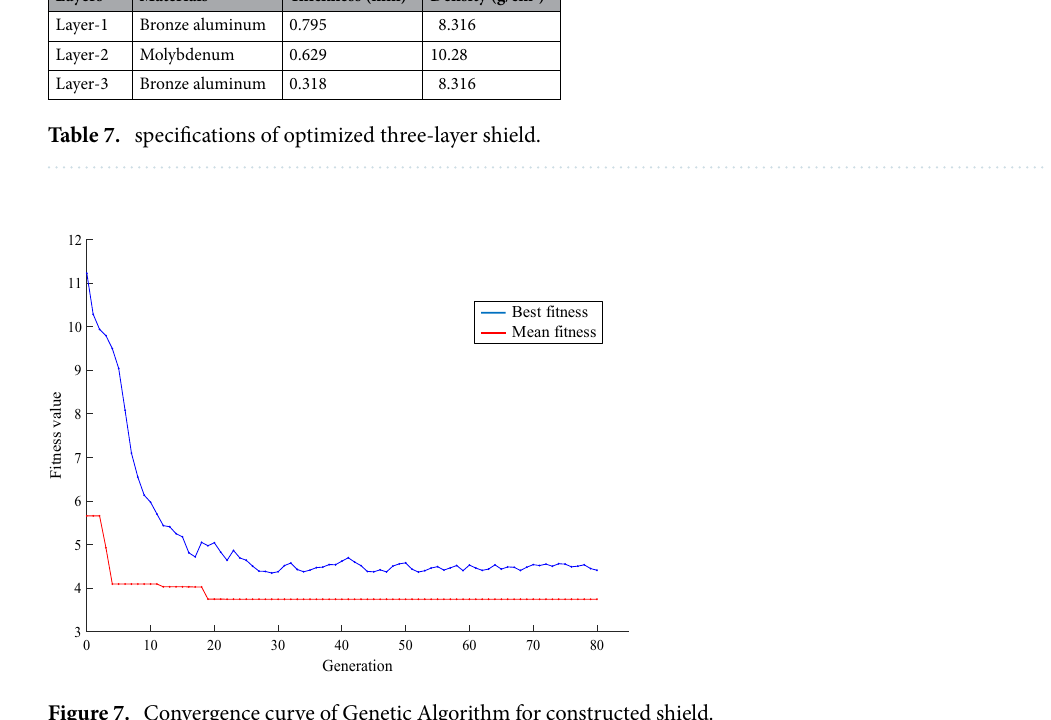
Figure 7. Convergence curve of Genetic Algorithm for constructed